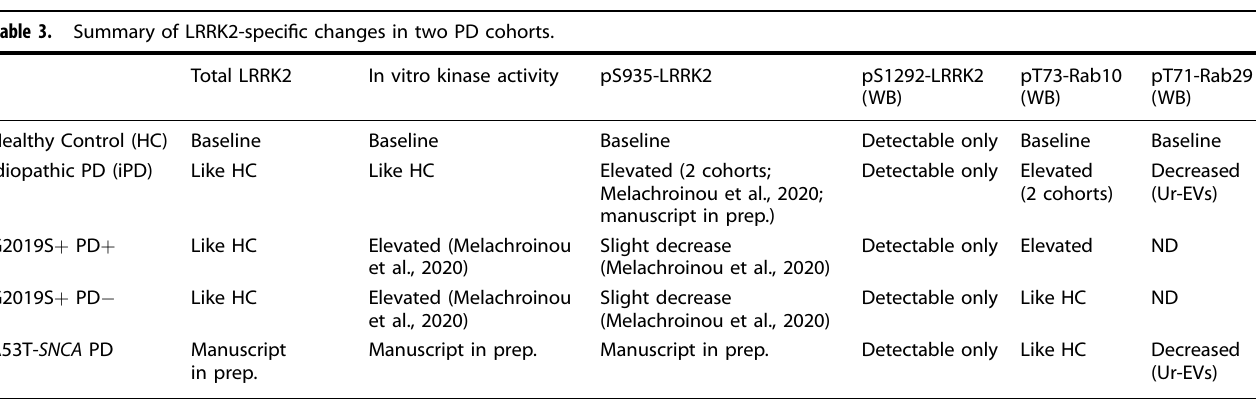
Table 3. Summary of LRRK2-speci fi c changes in two PD